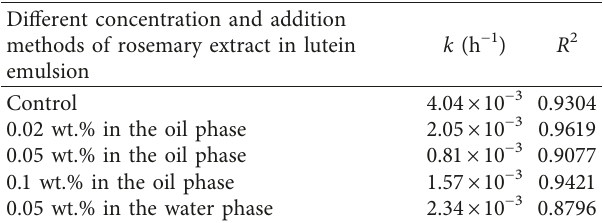
Figure 4: Effect of the rosemary extract (RE) addition in different phases (oil and water phase) on the degradation of lutein in WPI- stabilized emulsions during the storage at 55 ° C. Data points rep- resent means ( n � 3) ± standard deviations. Table 1: First-order reaction rate constant for heat degradation of lutein emulsion with different concentrations and addition methods of rosemary